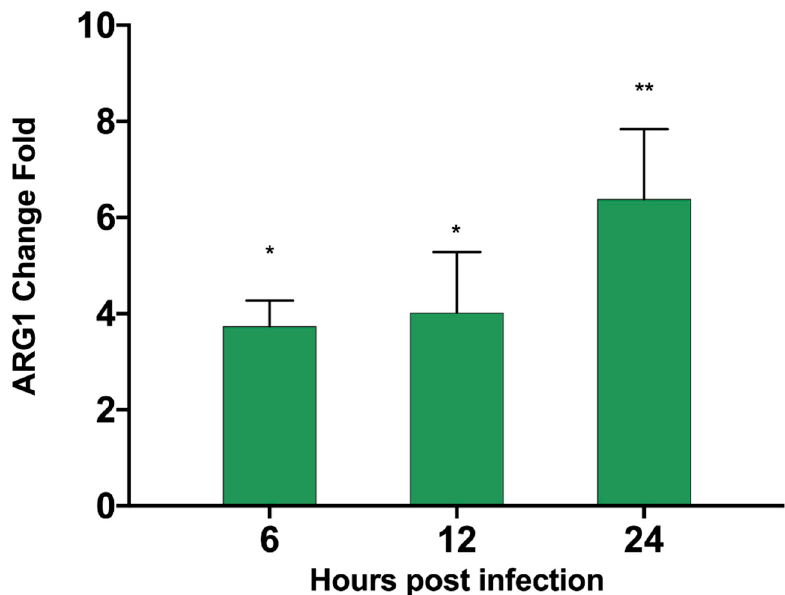
Figure 6. ARG1 mRNA fold change in PAM cells infected by ASFV. PAM cells were infected by ASFV. At 6, 12, and 24 h post-infection, the cells were harvested and mRNA was extracted. The transcription level of ARG1 was detected relative to the mock-infected group. The p values were calculated, ** p < 0.01, * p < 0.05.